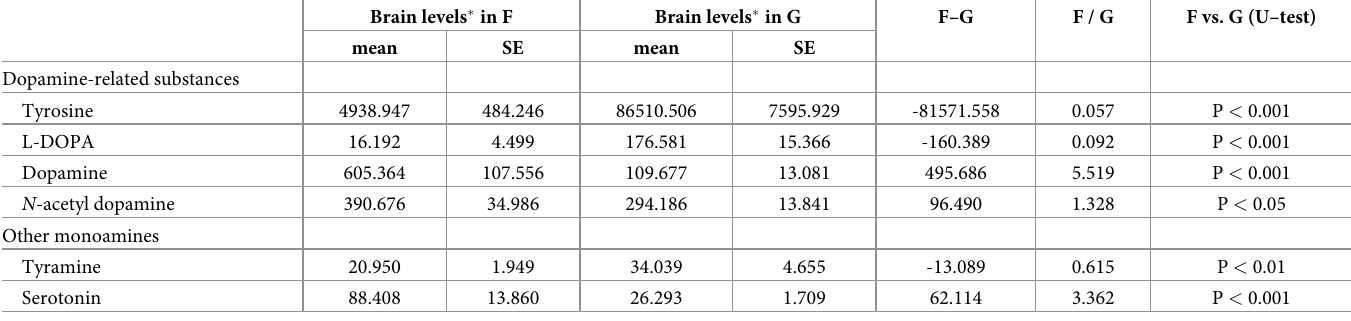
Table 1. Levels of dopamine-related substances and other monoamines in the brains of foundresses (F) and the comparison with those of newly emerged gynes (G) in Polistes rothneyi . Brain levels � in F Brain levels � in G F–G F / G F vs. G